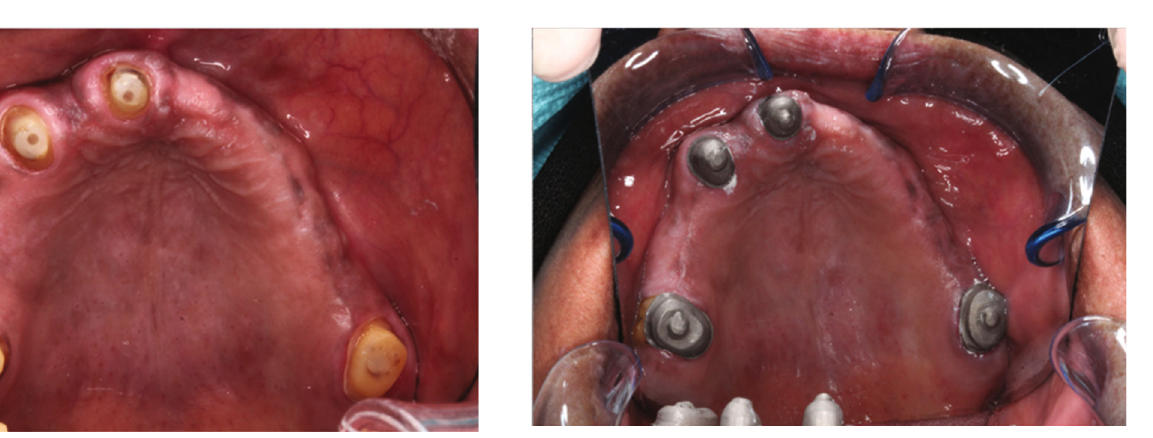
Figure 6: Orthopantomogram radiograph.